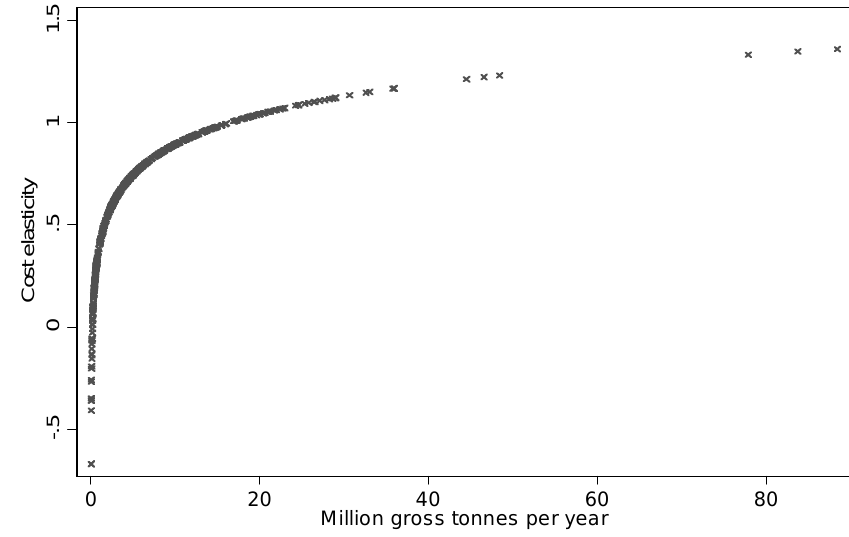
Figure 2. Maintenance cost elasticity with respect to output – Model